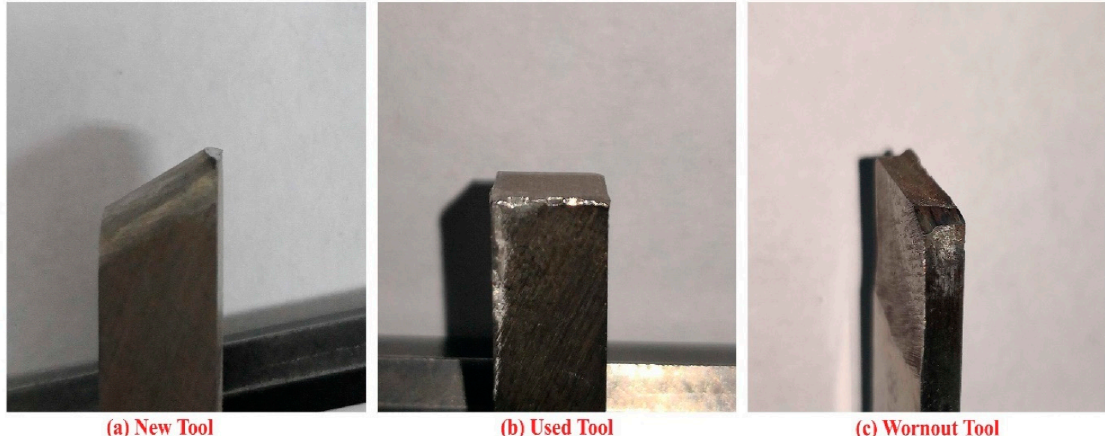
Figure 10. All three categories of high-speed steel (HSS) tool are shown where the level of tool degradation can be observed on each tooltip.